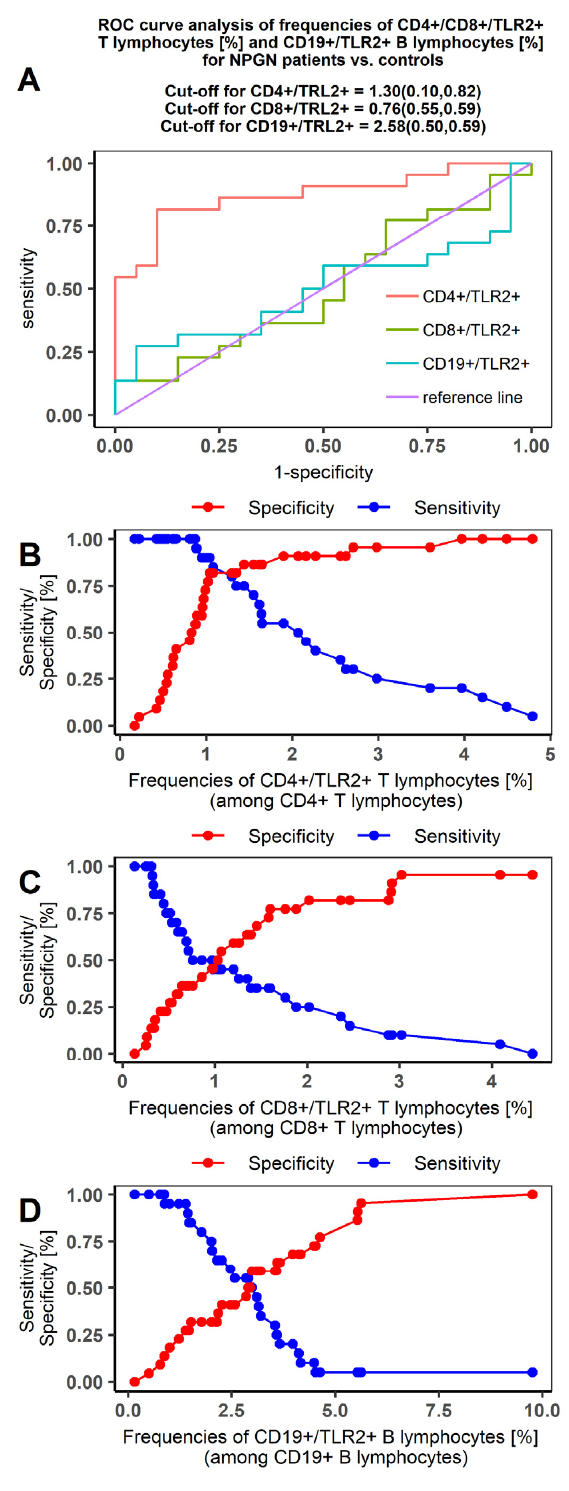
Figure 4. Receiver operating characteristic (ROC) curve analysis on the sensitivity and specificity of TLR2 expression to distinguish between NPGN patients and controls. ( A ) ROC curve analysis for CD4+/CD8+/TLR2+ T lymphocyte and CD19+/TLR2+ B lymphocyte frequencies (%) in NPGN patients; ( B ) sensitivity/specificity curve for CD4+/TLR2+T lymphocytes (%) in NPGN patients; ( C ) sensitivity/specificity curve for CD8+/TLR2+T lymphocytes (%) in NPGN patients; ( D ) sensitivity/specificity curve for CD19+/TLR2+B lymphocytes (%) in NPGN patients.